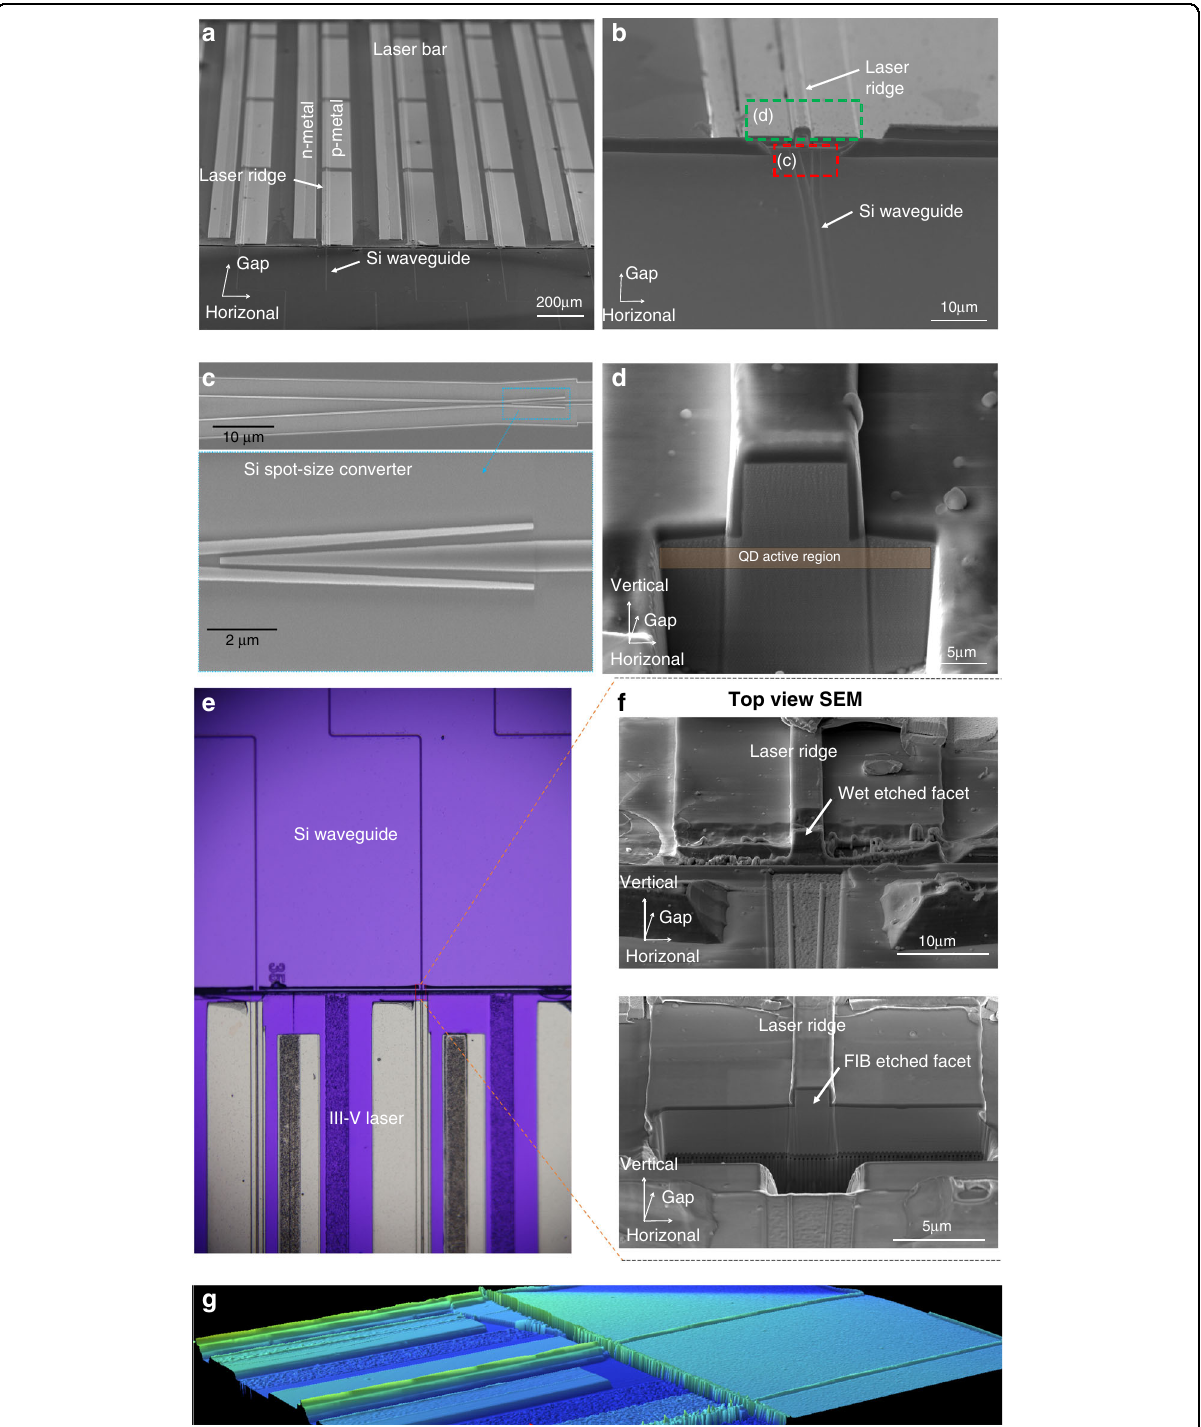
Fig. 4 Fabricated monolithically integrated InAs QD lasers coupled to silicon waveguides. a Tilted SEM image of entire integrated chip. b SEM image of fabricated narrow ridge laser directly coupled with silicon waveguides using fork-like mode converter. c SEM image of silicon waveguide mode converter. d Magni fi ed SEM image of single embedded laser edge-coupled with silicon waveguide. e Optical microscope of monolithically integrated laser and silicon WG. f SEM images of the embedded lasers with wet etched and FIB etched facets, respectively. g White light interferometric image of the fi nalized